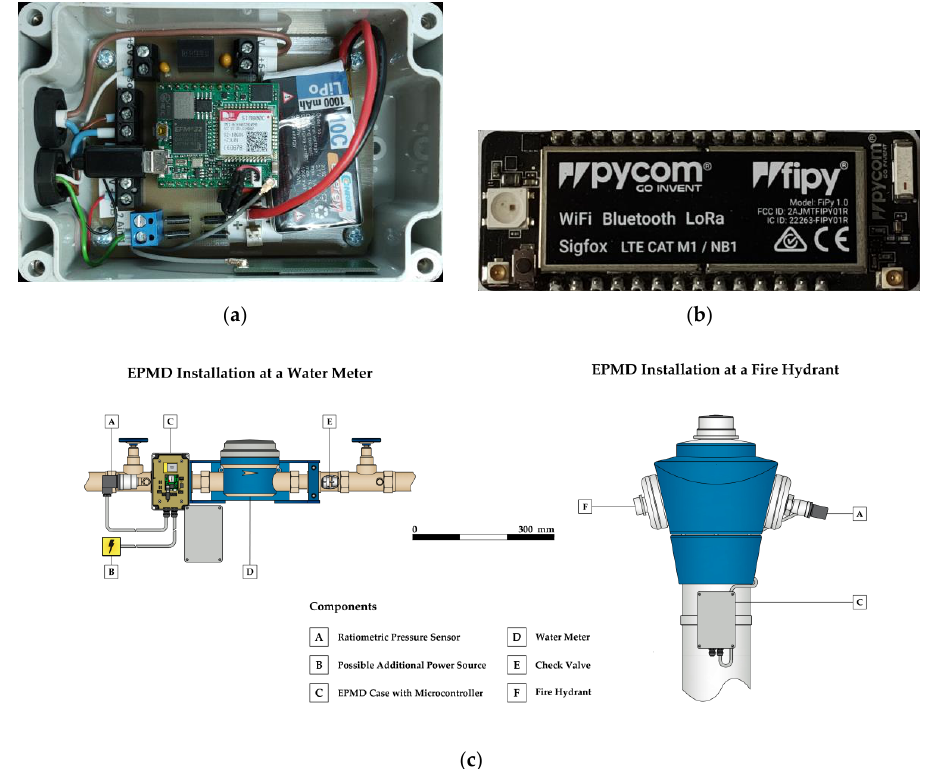
Figure 1. A microcontroller (MCU) with SIMCom SIM800C (general packet radio service, GPRS) communication module ( a ), MCU with Sequans Monarch (NB-IoT) and Semtech SX1272 (long-range wide area network, LoRaWAN and Sigfox) communication modules ( b ); schematic representations of energy-efficient pressure-monitoring device (EPMD) prototype installation at a water meter and at a fire hydrant ( c